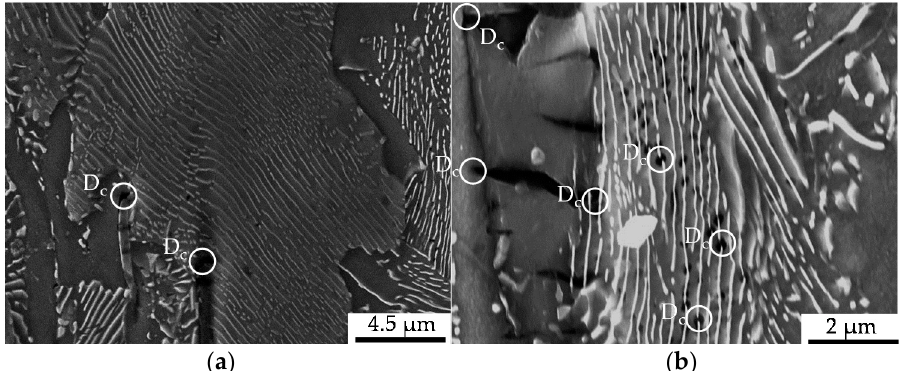
Figure 12. Cyclic damage (D c ) induced under cyclic compression–tension load paths: ( a ) detailed view of isotropic crack growth at the tips of MnS-inclusions; ( b ) detailed view of MnS-inclusion assisted microcrack growth ( left ) and pore nucleation in the pearlite phase.